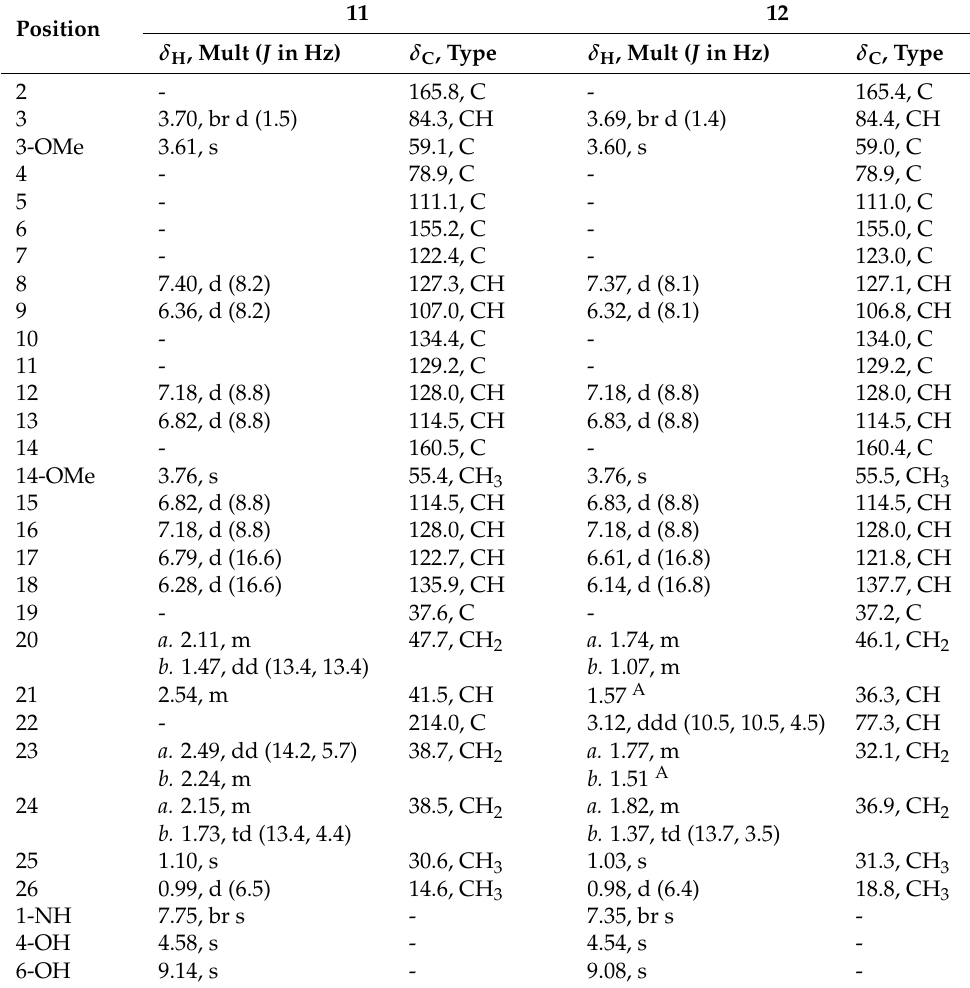
Table 3. 1D NMR (600 MHz, CDCl 3 ) data for aflaquinolones H–I ( 11 – 12 ).